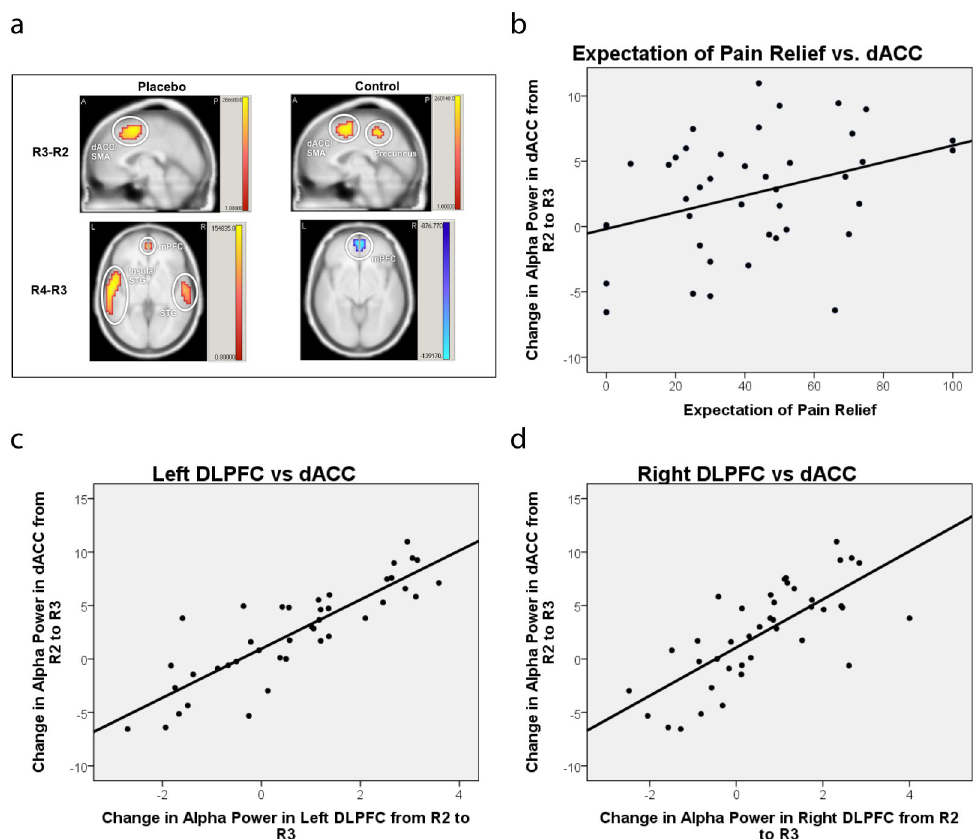
Figure 2. Significant sources of alpha activity. ( a ) Contrasts shown are R3-R2 (top) and R4-R3 (bottom) in the healthy placebo (left) and healthy control groups (right). Both groups demonstrated significantly increased activity in the dACC/SMA from R2 to R3. From R3 to R4, alpha activity increased in the bilateral mPFC and left insula in the placebo group, but decreased in the mPFC in the control group. The false discovery rate was q ≤ 0.005. ( b ) The change in alpha activity in the dACC/SMA from R2 to R3 significantly correlated with expectation of pain relief in the placebo group (r = 0.357, p = 0.022). ( c ) Correlation between change in alpha power in the left DLPFC from R2 to R3 and the change in alpha in dACC/SMA. ( d ) Correlation between change in alpha power in the right DLPFC from R2 to R3 and the change in alpha in dACC/SMA. There were a significant positive correlations between change in alpha in the dACC/SMA and in the left and right DLPFC from R2 to R3 ( p < 0.001). Abbreviations: R2, recording 2; R3, recording 3; R4, recording 4; DLPFC, dorsolateral prefrontal cortex; dACC, dorsal anterior cingulate cortex; SMA, supplementary motor area; mPFC, medial prefrontal cortex; STG, superior temporal